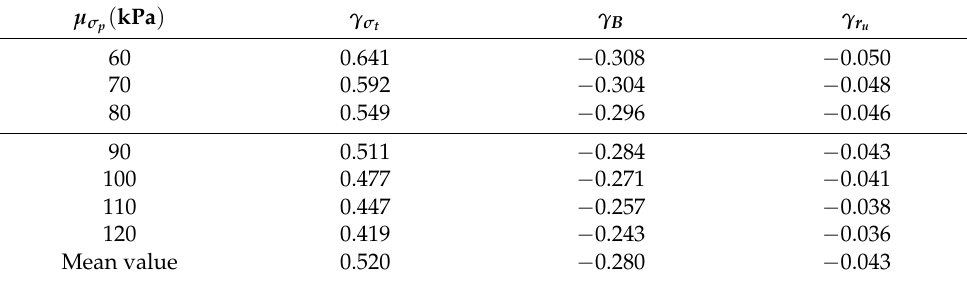
Table 3. Sensitivities for different support